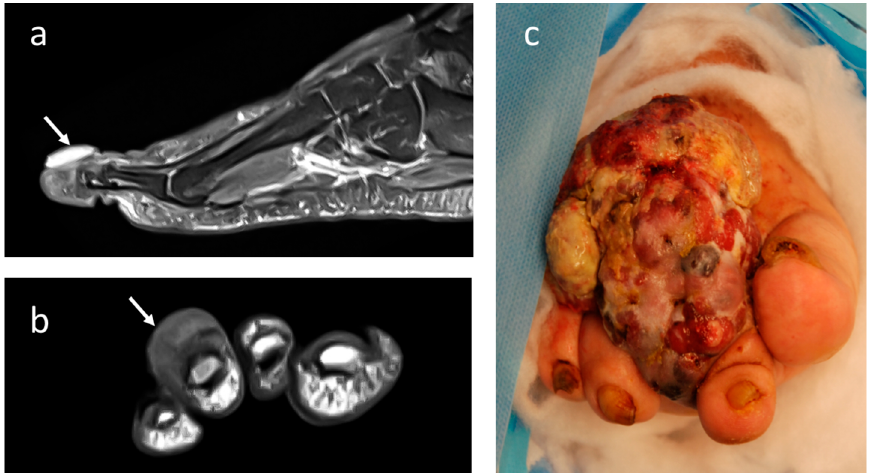
Figure 4. Imaging appearance at T2-weighted MRI with contrast-enhancement in ( a ) sagi tt al and ( b ) coronal projection of acral melanoma of the 3rd distal foot phalange (small arrows). ( c ) Clinical ap- pearance of large melanoma a ff ecting the foot in a 70-year-old female patient.